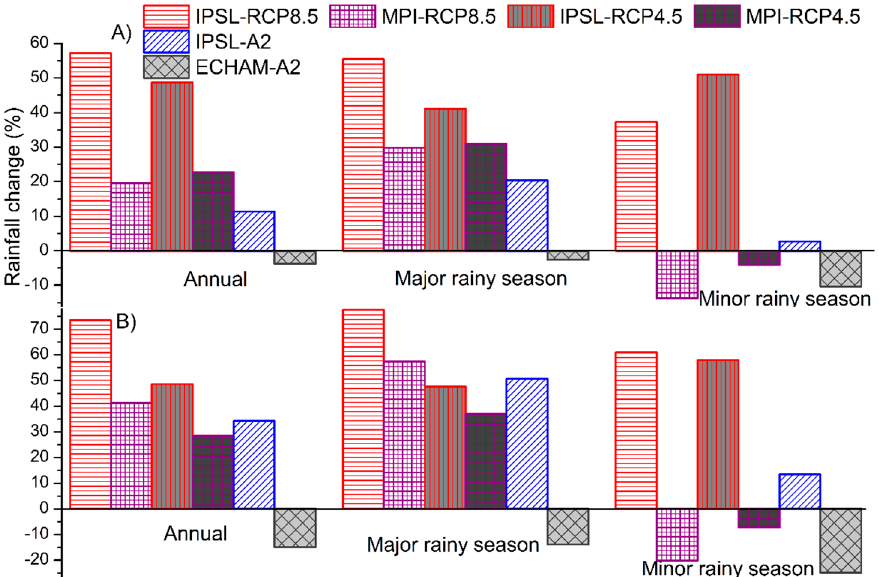
Figure 11. Percentage changes of annual and seasonal rainfalls for ( A ) the near future period of 2021–2050, and ( B ) the far future period of 2071–2100, with reference to the baseline.